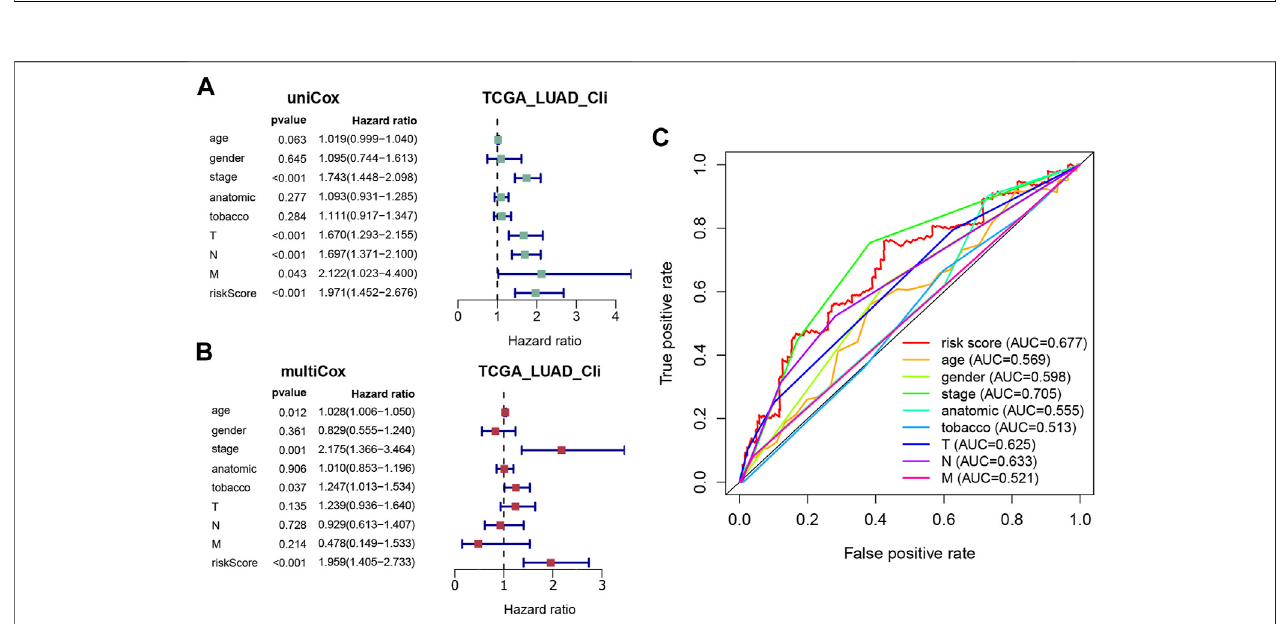
FIGURE 4 | Evaluation of the prognostic accuracy of the model and other clinicopathological characteristics. (A,B) Univariate and multivariate Cox regression analyses of the risk score and other clinical parameters (age, gender, AJCC stage, anatomic location, tobacco history, T, N, and M). (C) ROC curves for the risk score (AUC = 0.677) and other clinical